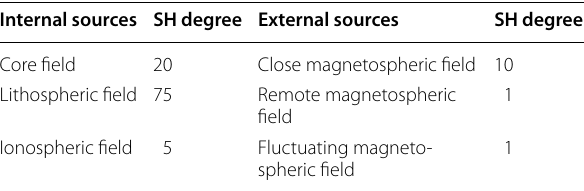
Table 1 The six magnetic sources simulated by the Kalmag model and their used spatial resolution Internal sources SH degree External sources SH